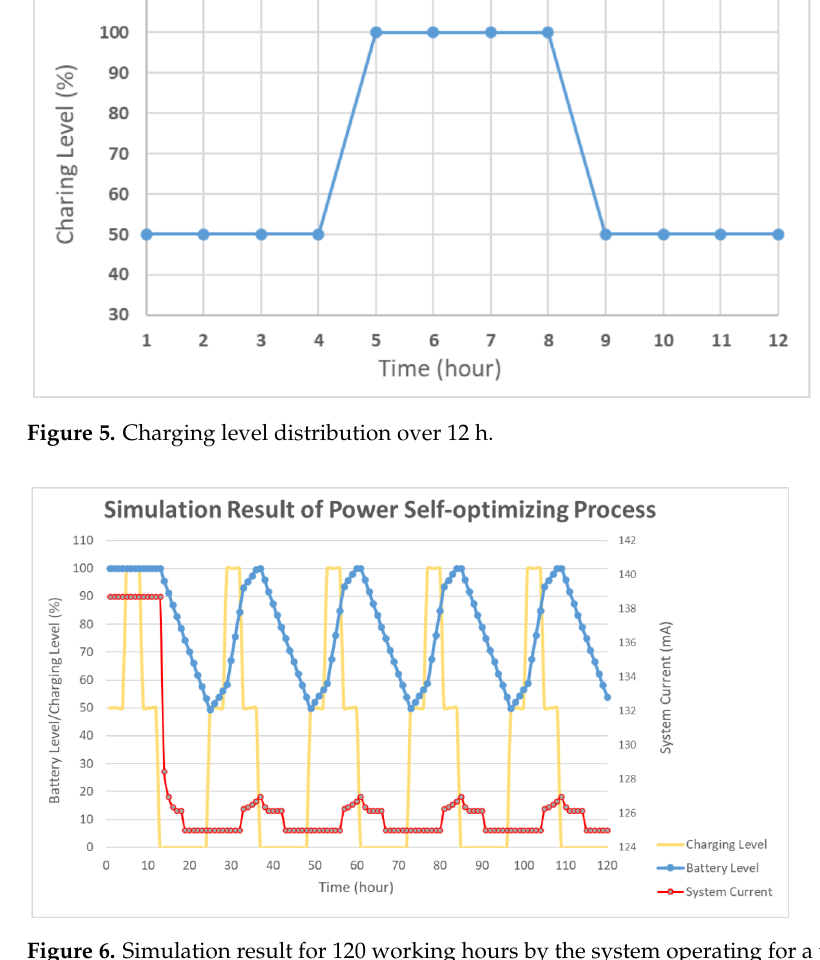
Figure 6. Simulation result for 120 working hours by the system operating for a period of 1 h.